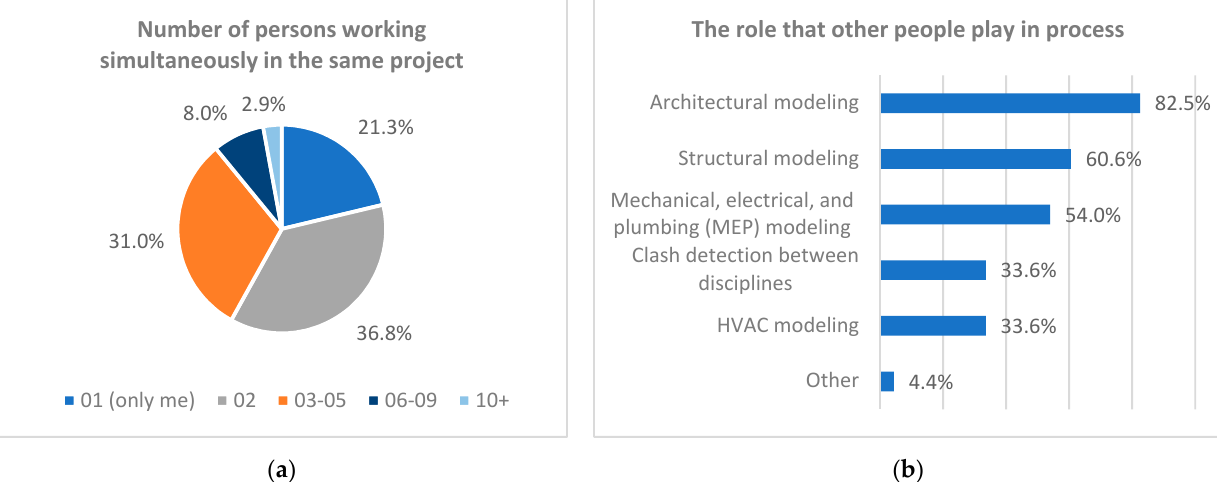
Figure 17. Collaborative work charts. ( a ) Chart showing the number of persons working simultaneously in the same pro-